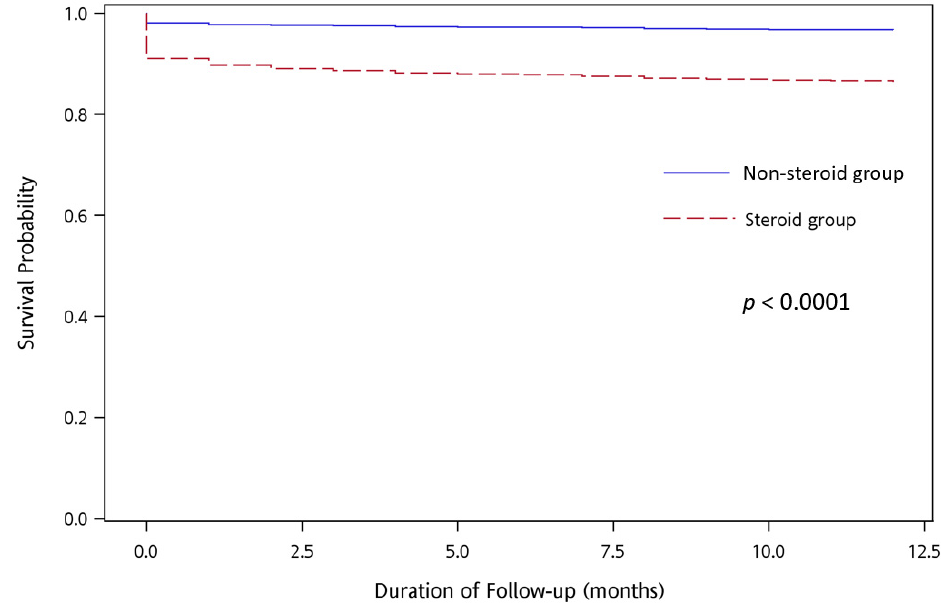
Figure 2. Kaplan–Meier plots indicating the percentage of survival probability in pediatric patients with acute bacterial meningitis during the 1-year follow-up period ( p -value was obtained by log-rank comparison of data).